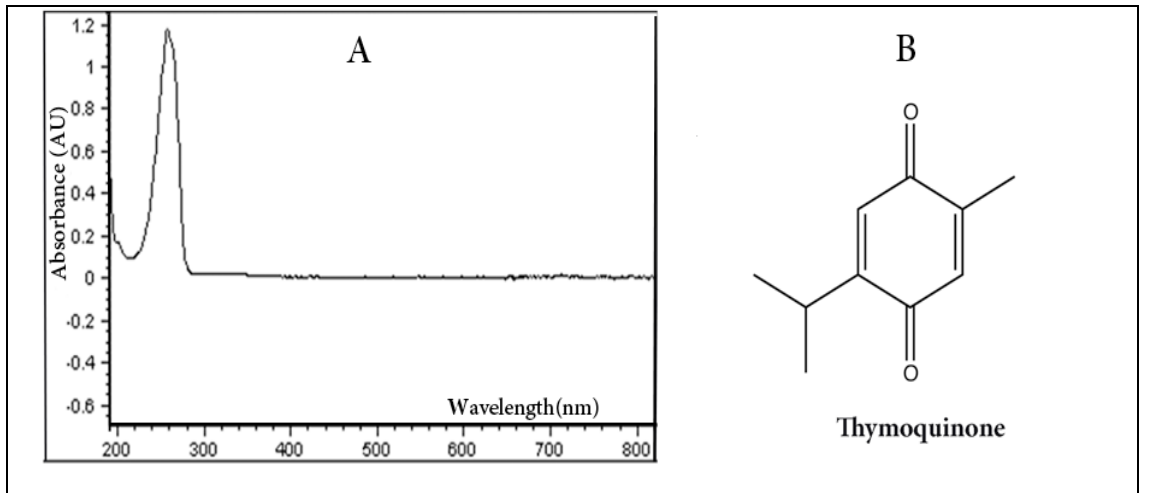
Figure 1. The UV-VIS spectrum of TQ (10 μ g/mL) in ethanol ( A ) and the chemical structure of the drug ( B